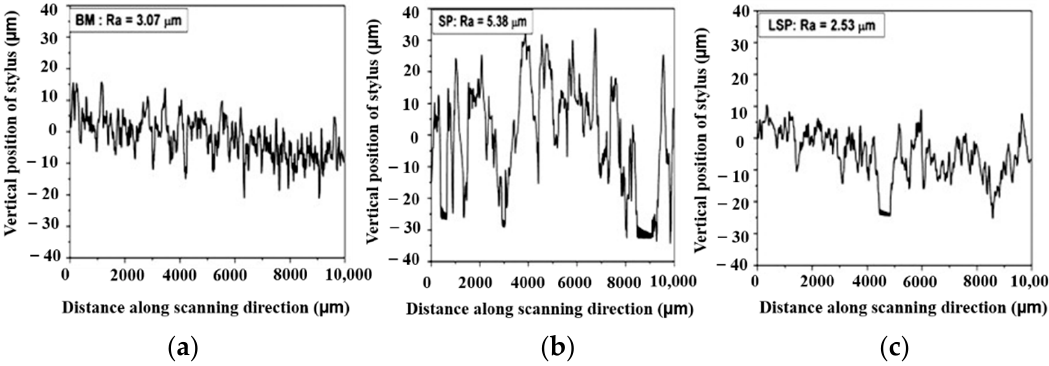
Figure 15. Surface profile comparisons ( a ) BM; ( b ) SP and ( c ) LSP treated specimen. Reproduced with permission from [117]. Copyright Elsevier, 2012.